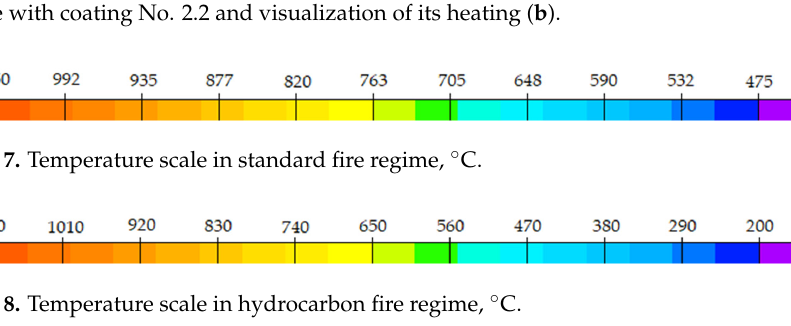
the test samples. shows the averaged values of thermocouple values, located in the middle of the height of